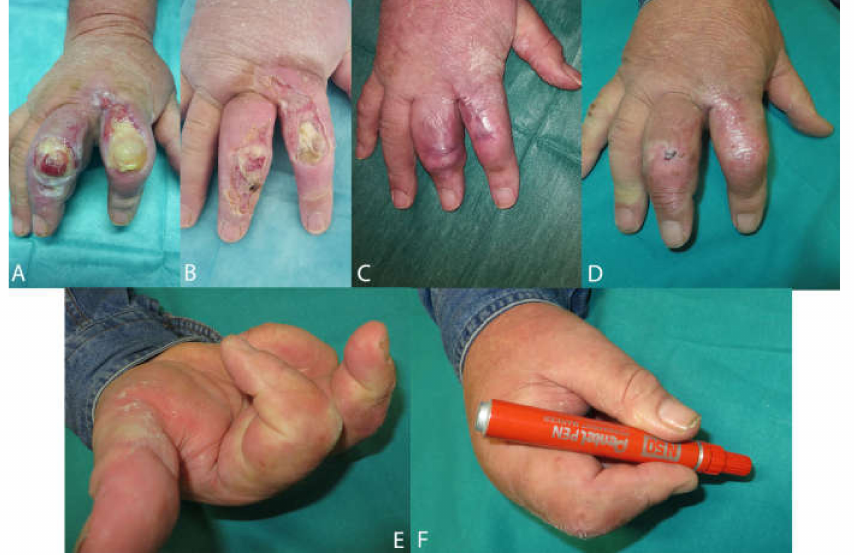
Figure 7. Burn case. MR, 70 y/o. Presence of periwound inflammation sign and Class 3 periwound tissue by HPS classification. Appearance of the wound before the treatment ( A ). Wound aspect after 2 weeks ( B ). Wound aspect after 4 weeks ( C ) and final aspect with complete reepithelialization after 8 weeks ( D ). Good motor function of the hand ( E , F